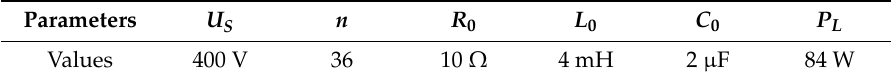
Table 3. The parameters of each part in the medium-voltage experimental prototype.